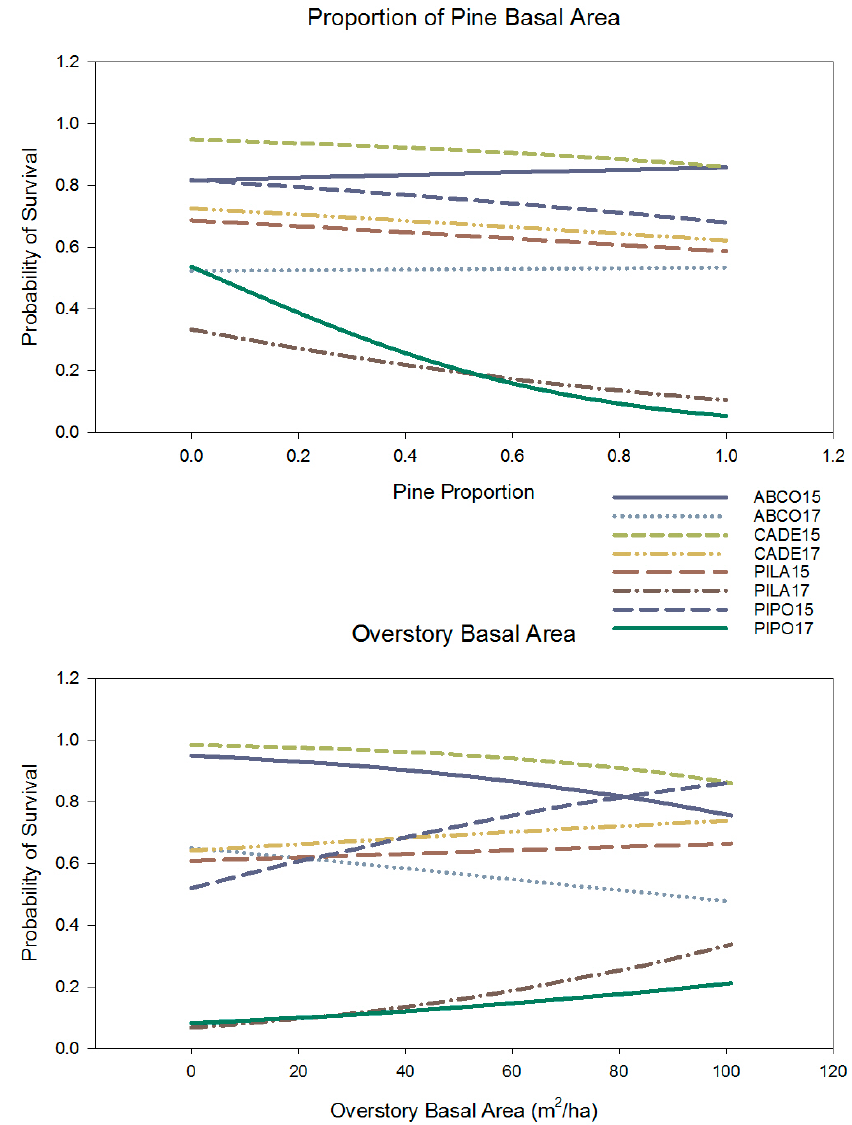
Figure 5. Probability of survival by species based on logistic regression of plot level proportion of pine overstory basal area (upper insert; scaled from 0.0–1.0, with 1.0 equally all basal area in pine) and total overstory basal area (lower insert; m 2 /ha) in Spring 2015 and Summer 2017 in the Southern Sierra Nevada. Abies concolor , ABCO; Caleocedrus decurrens , CADE; Pinus lambertiana , PILA; Pinus ponderosa , PIPO.